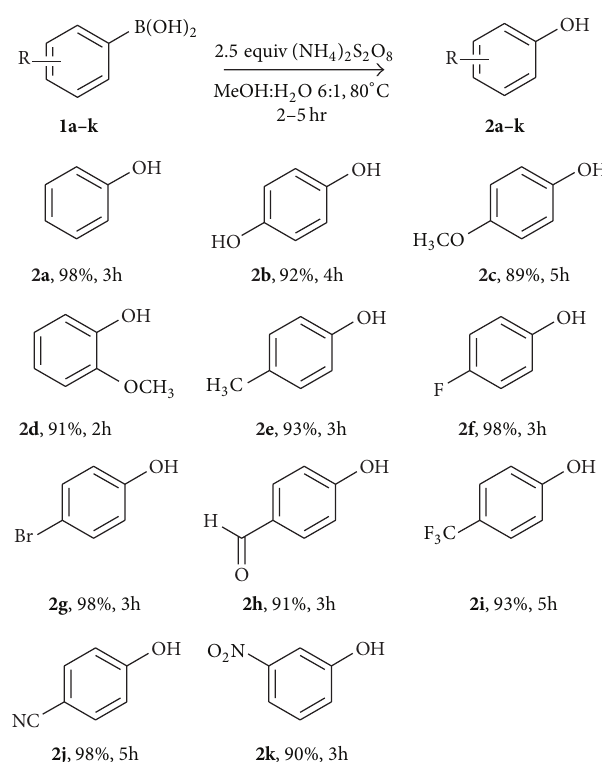
Scheme1:Thehydroxylationreactionsof 1 a –1 k .Yieldoftheisolated product. All compounds were characterized by 1 H NMR and 13